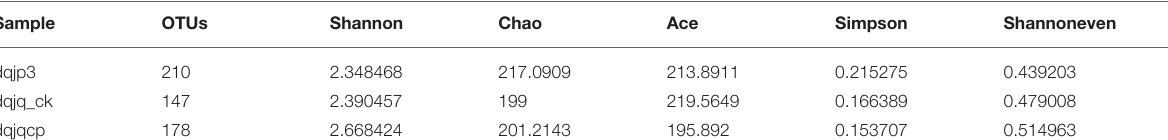
TABLE 1 | α -Diversity indexes in three samples.